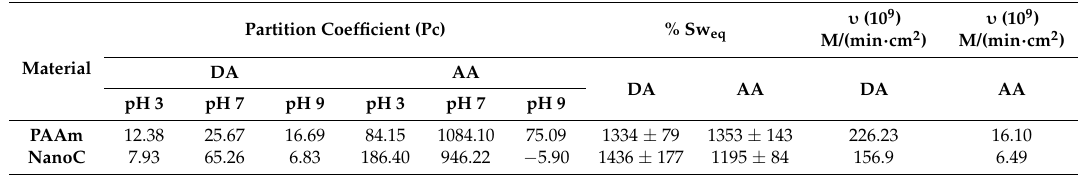
Table 2. Physicochemical parameters: Partition coefficients of DA and AA in PAAm and NanoC materials, Equilibrium Swelling Percentages in DA and AA solution (%Sw eq ) at pH 7 and initial release rates ( υ ).